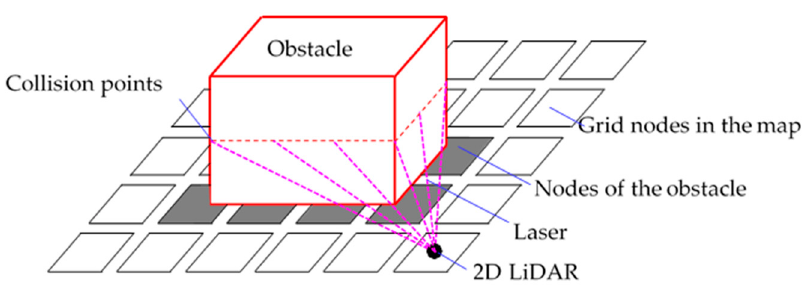
Figure 13. Obstacle judgment of the A* algorithm.